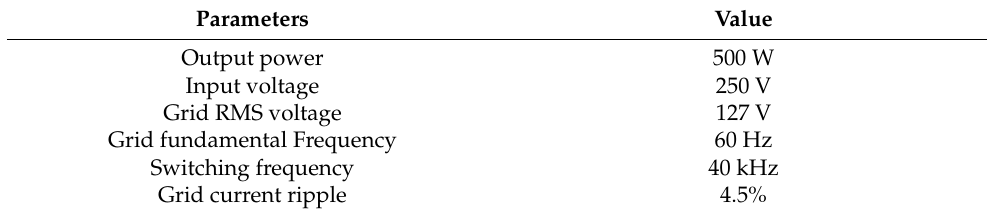
Table 1. Parameters for designing the L